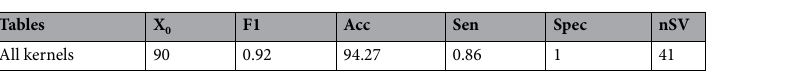
Table 4. MKL results obtained from combining 24 kernel matrices derived from the datasets (4 kernels per dataset).